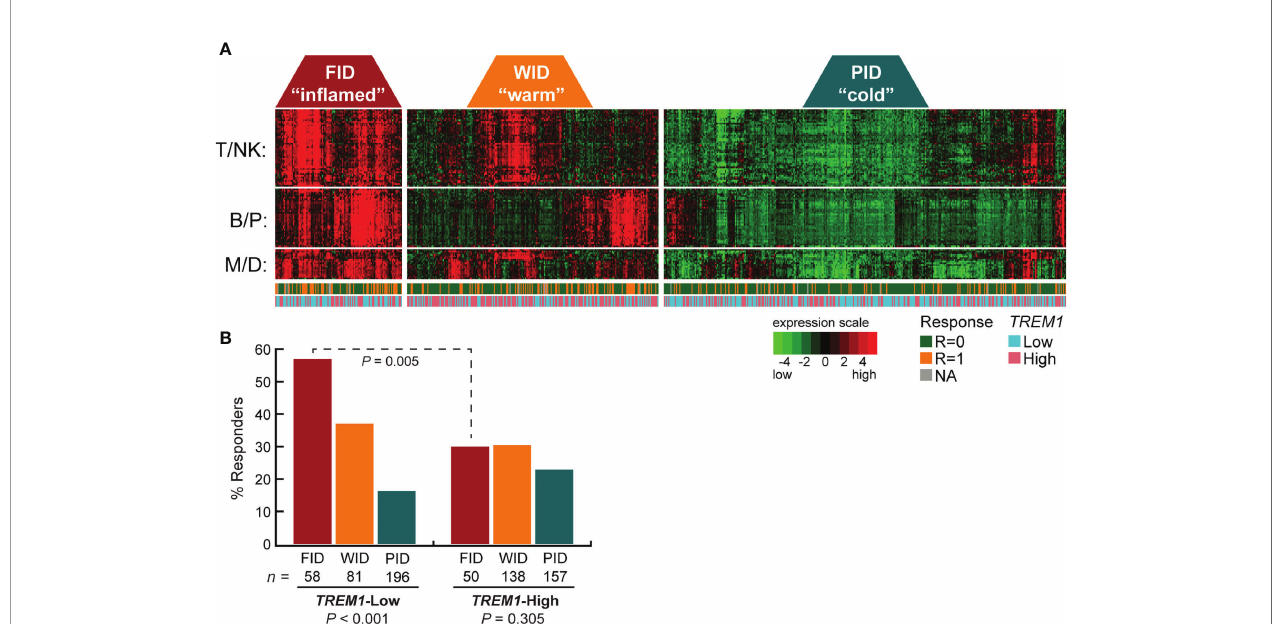
FIGURE 1 | High TREM1 expression in breast tumor biopsies associates with reduced ef fi cacy of neoadjuvant chemotherapy in tumors with high effector immune in fi ltrates. The breast tumor biopsy expression pro fi ling data set of Alistar et al. (15) was used to evaluate interactions between TREM1 expression and neoadjuvant chemotherapy response within immune subclasses. (A) Heatmap of the genes comprising the T/NK (T cell/NK cell), B/P (B-cell/Plasma cell), and M/D (Myeloid/ Dendritic cell) gene signatures are shown for tumors classi fi ed into the FID, WID and PID immune subclasses (see Materials and Methods for additional details). Tumor response to neoadjuvant chemotherapy (1 = responder, 0 = nonresponder) and tumor TREM1 expression level (Low = below median, High = above median) are indicated beneath the heatmap. (B) The fraction of chemotherapy-responsive tumors (Y-axis) is shown for each immune subclass as a function of low or high TREM1 (X-axis). Chemotherapy response rates were compared across immune subclasses (within low or high TREM1 groups) and within immune subclasses (across low and high TREM1 groups) by Chi-square test with Yates correction. Only the FID subclass exhibited a difference in chemotherapy response across TREM1 low and high tumors ( P =